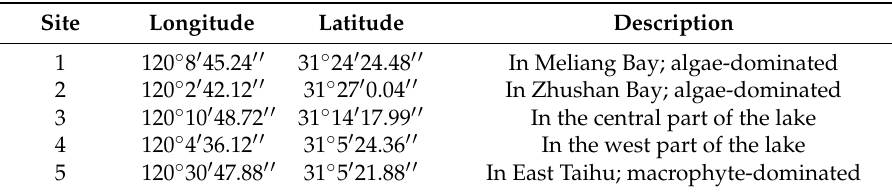
Figure 1. Locations of Lake Taihu in China and sampling sites in Lake Taihu. Table 1. Location of sampling sites in Lake Taihu.